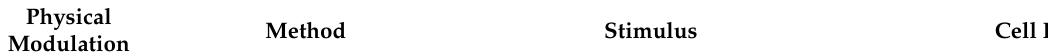
Table 1. Examples of physical modulation and cell